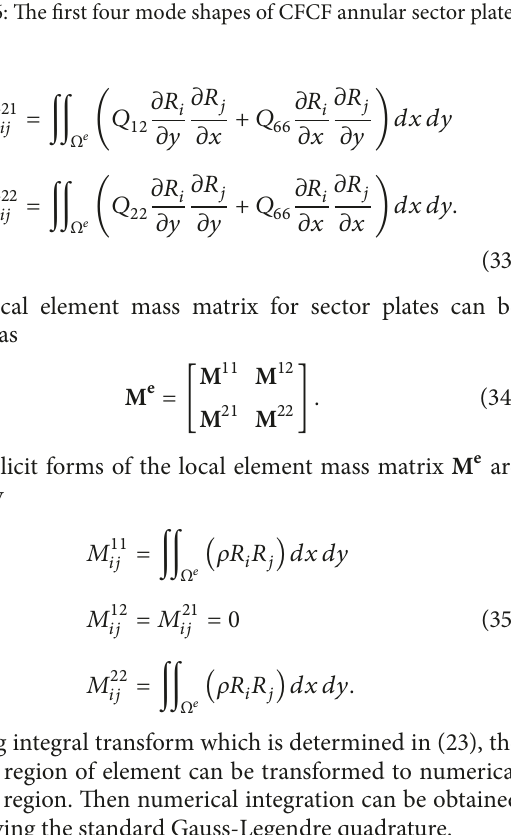
Figure 6: The first four mode shapes of CFCF annular sector plate ( 𝑅 0 /𝑅 1 = 0.5 ) with different sector angles, that is, 𝜙 = 90 ∘ , 180 ∘ , and 300 ∘